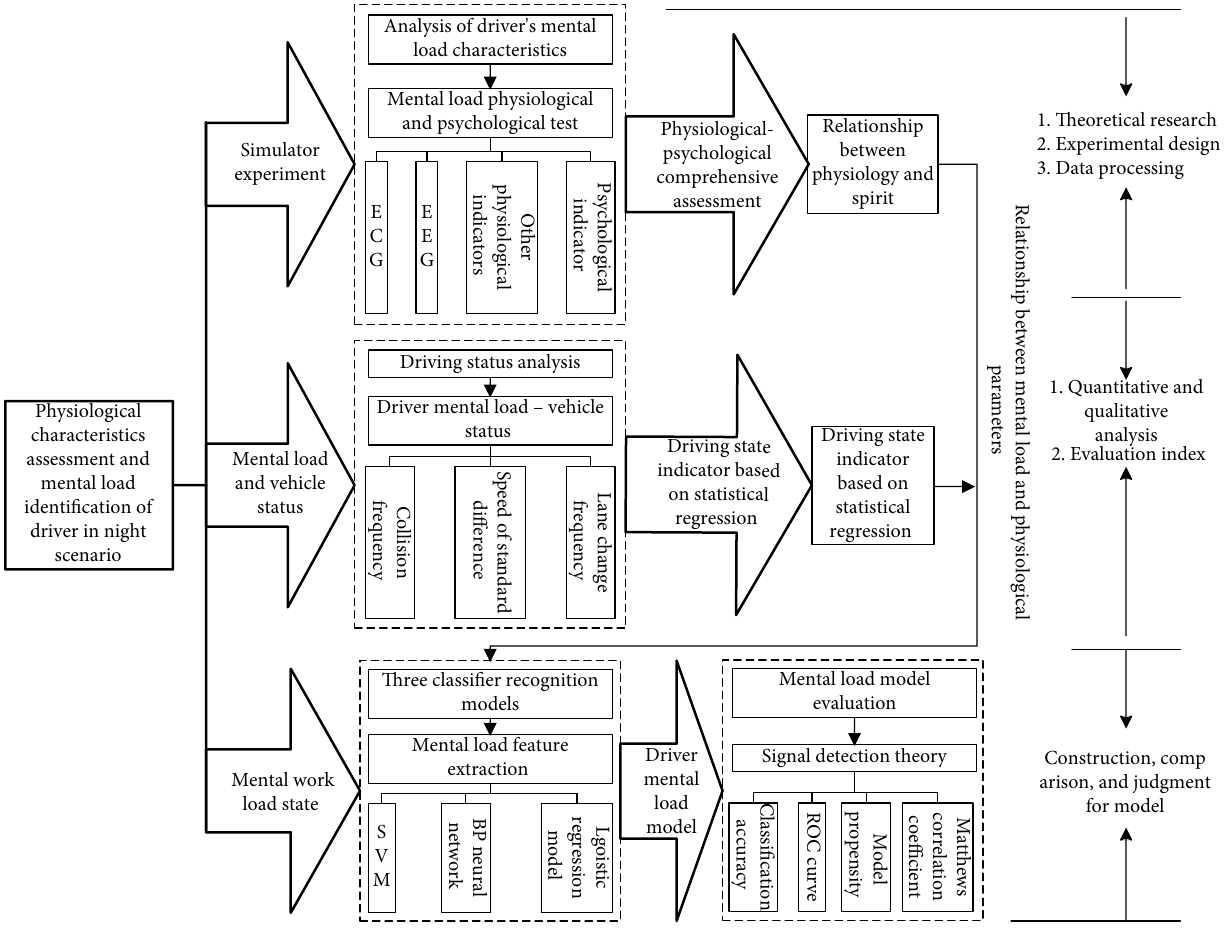
Figure 1: The framework of the